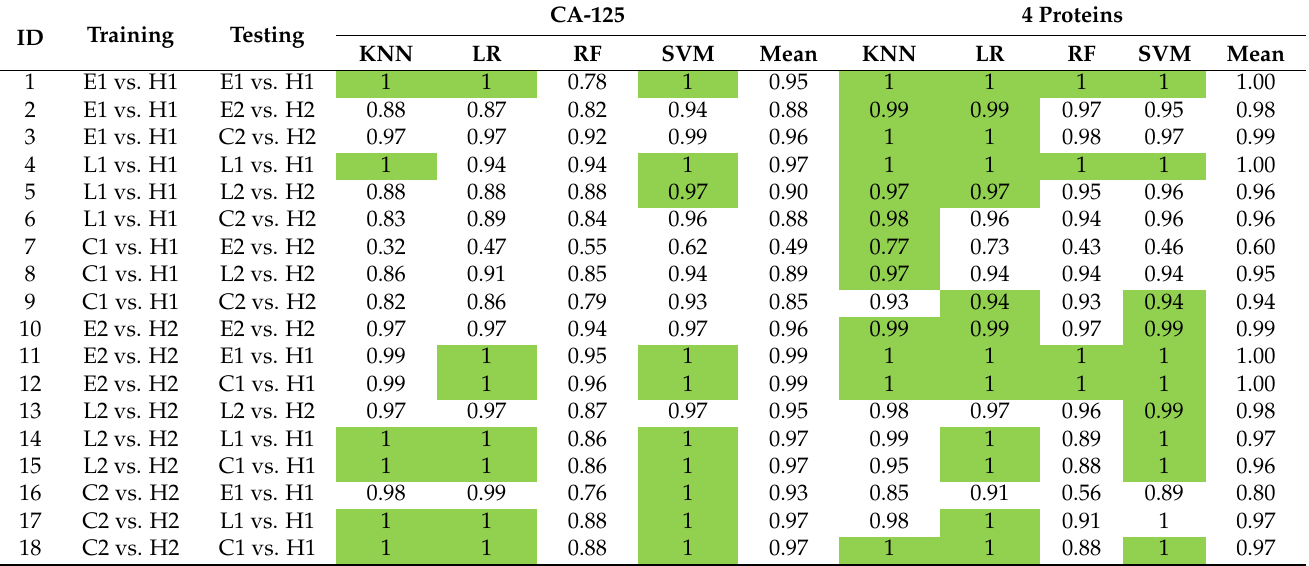
Table 4. The comparison of specificity between CA-125 alone and all four proteins (CA-125, MIF, OPN, and PROL) when using the four classification techniques, namely K-Nearest Neighbor (KNN), Logistic Regression (LR), Random Forest (RF), and Support Vector Machine (SVM). The specificity measures the ability to correctly identify control samples and is defined as the ratio of the number of control samples correctly classified to the total number of control samples. We highlighted the cell(s) with best specificity in each experiment. Using logistic regression and all four proteins yield the best results on most occasions.